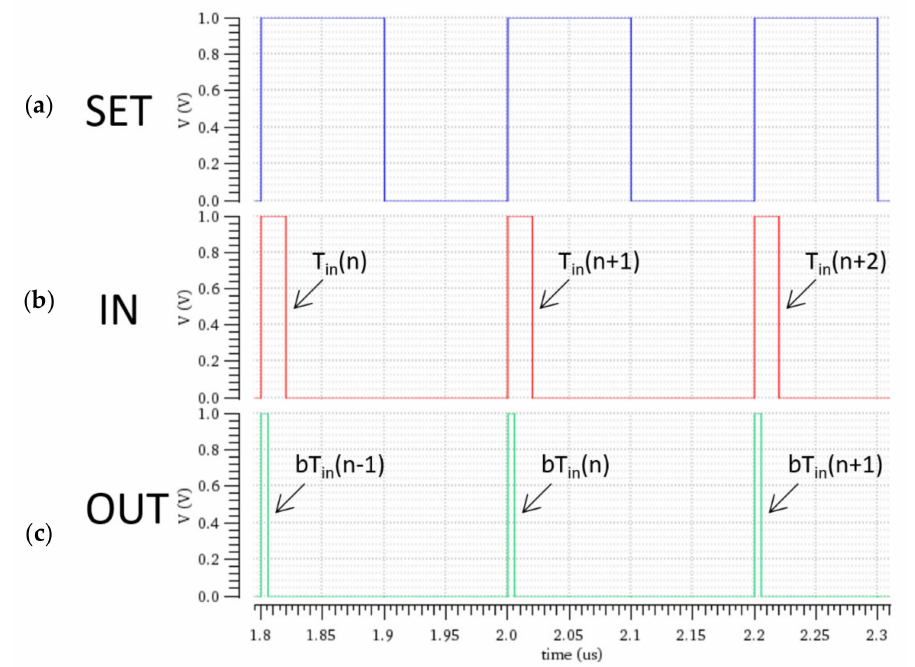
Figure 10. Timing waveforms for the z − 1 multiplier for a multiplication coefficient equal to 0.28, ( a ) synchronization clock, ( b ) input pulses width with T in = 20 ns and ( c ) output pulses with pulse width T out = 5.55 ns.